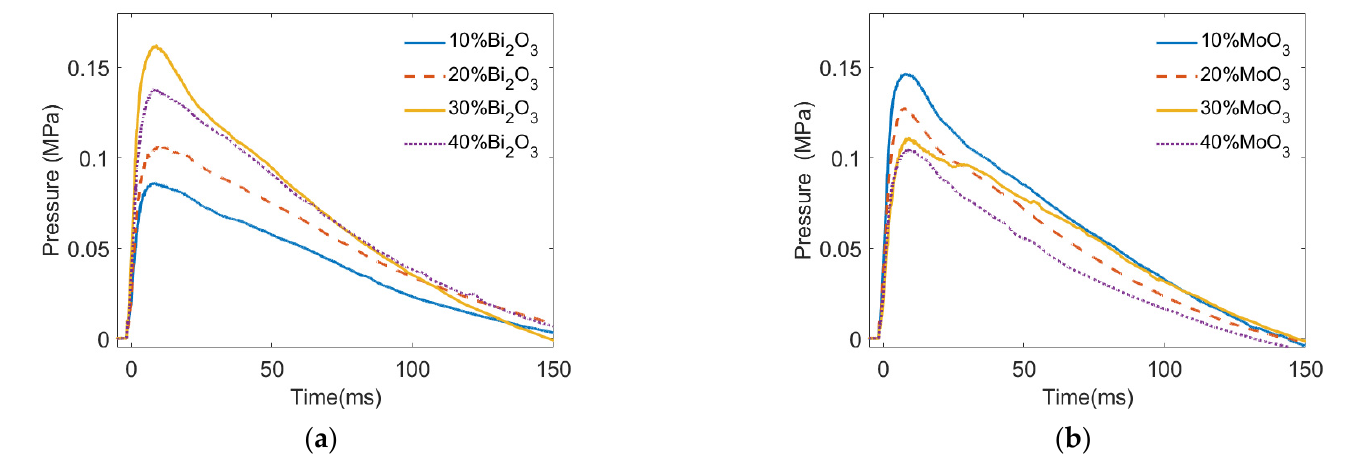
Figure 4. The pressure varied with time in the test chamber: ( a ) PTFE/Al/Bi 2 O 3 ; ( b ) PTFE/Al/MoO 3 . The pressurization characteristics of PTFE/Al/oxide are listed in Table 3. The quasi- static pressure peak ( P max ), impulse, and duration time were used to characterize the pressurization and energy release performance of the PTFE/Al/oxide energetic materials. The experiments showed that when the impact velocity ranged from 904 m/s to 971 m/s, the